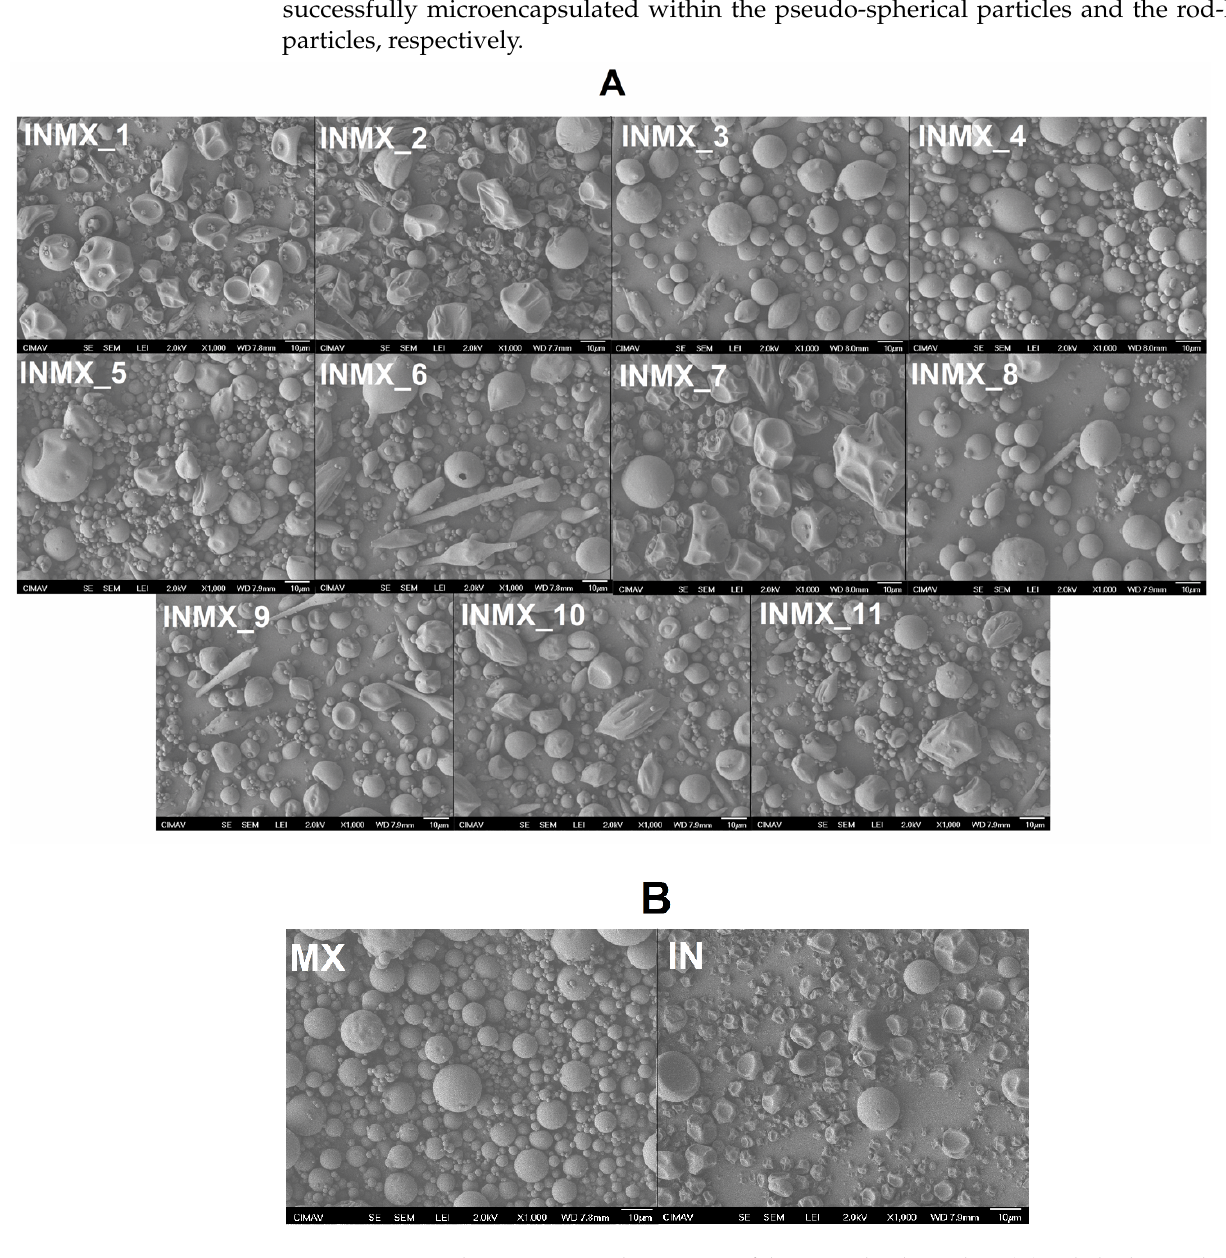
Figure 1. Acquired SEM micrographs at 1000× of the spray-dried powders: ( A ) carbohydrate polymers blends, and ( B ) blank samples.